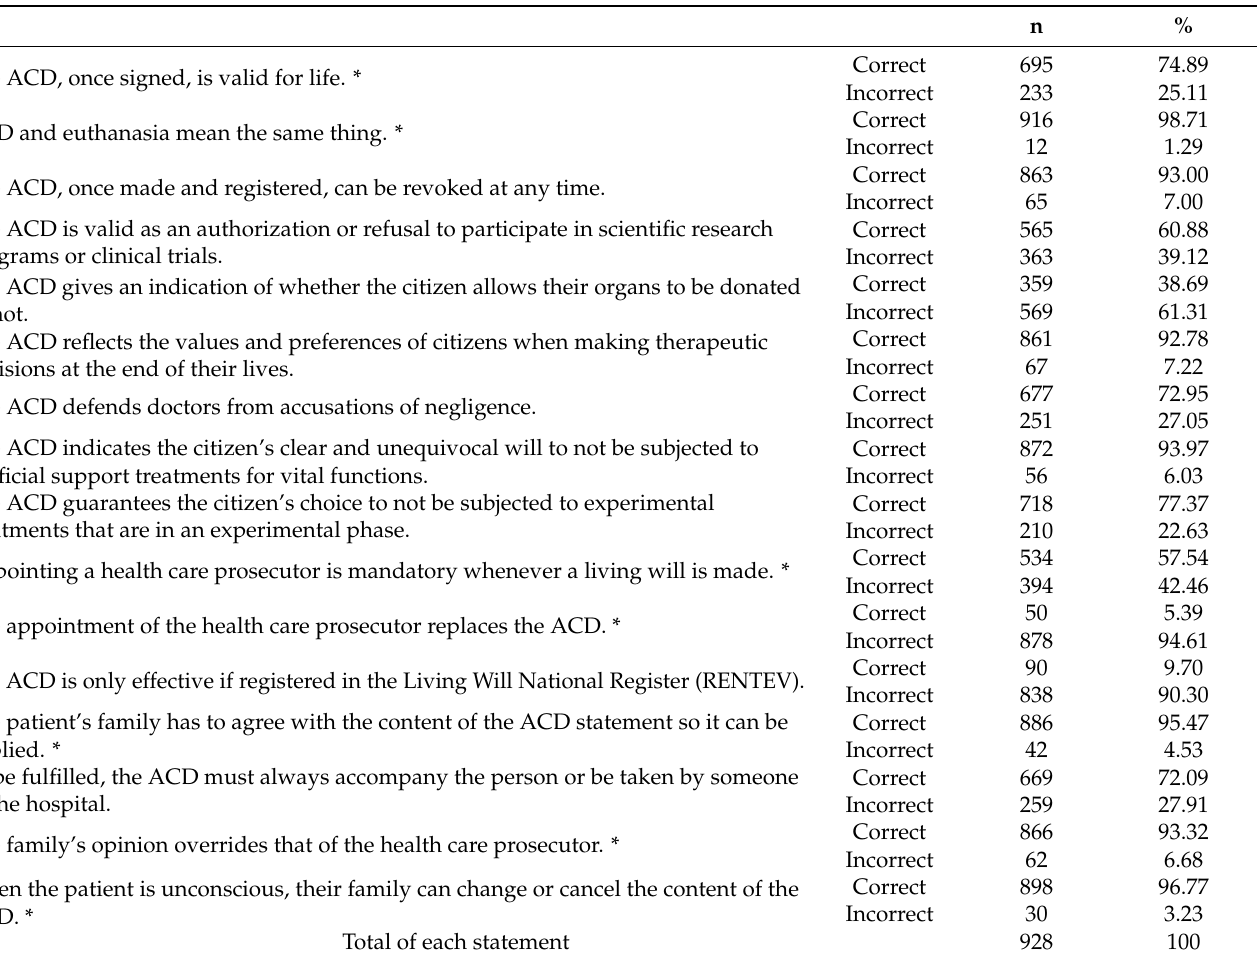
Table 2. Sample distribution for each ADKS item .